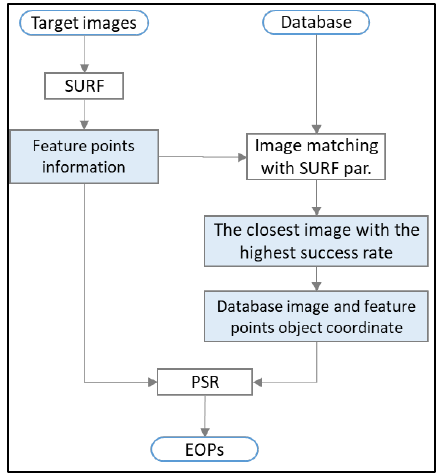
Figure 6. Visual-based absolute navigation model flow chart Figure 7 is the illustration of visual-based absolute navigation